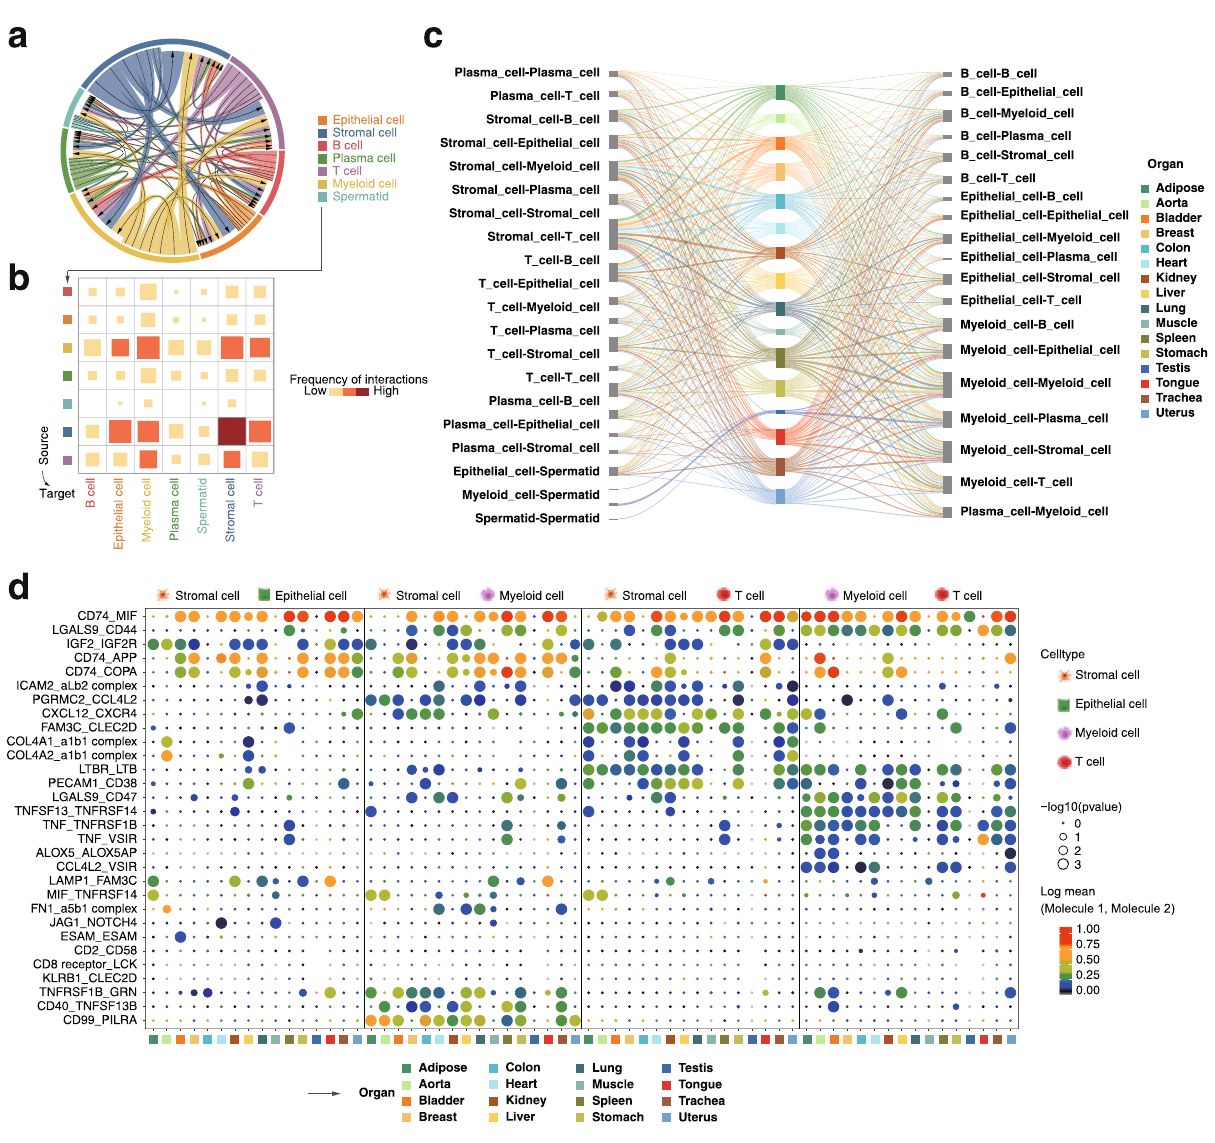
Fig. 5 Dynamics of cell – cell communication networks. a Chordal diagram of the integrated cell – cell interaction network among the major cell types. b Heatmap showing the interaction intensity of cellular interactome from ( a ). Block sizes and colors are proportional to the interaction frequency. c Sankey diagram demonstrating the cell – cell interactions of different cell types in 16 organs. The thickness of lines represents the strength of cell – cell interactions. d Ligand – receptor interactions between selected cell subtypes in different organs. Each row represents a ligand-receptor pair, and each column de fi nes a pair of cell – cell interaction. P-values were calculated by CellPhoneDB without multiple Fig. 7e, including cell identities such as HNF4A , HNF4G and CDX2 for enterocyte cells (Fig. 7f), POU2F2 and BCL11A for B